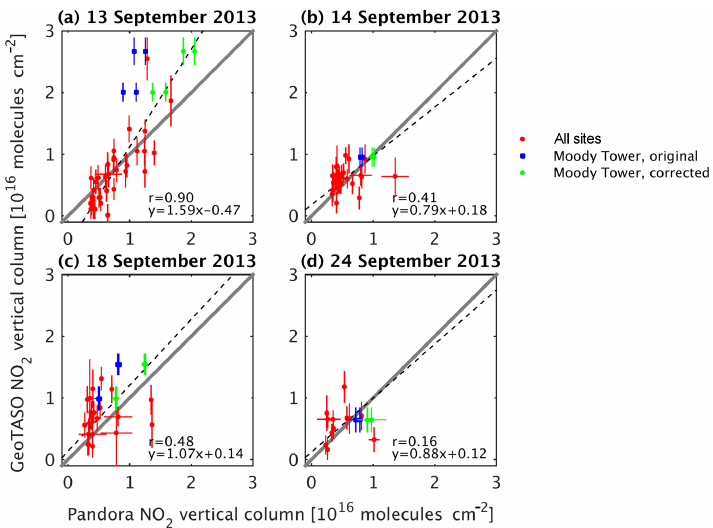
Figure 13. Pandora NO 2 vertical columns vs. GeoTASO NO 2 total vertical columns (retrieved tropospheric column plus modeled strato- spheric column) for cloud-free observations during four Houston urban flights during DISCOVER-AQ 2013. Data collected at the Moody Tower site (70m) have been corrected for the partial NO 2 column below the tower (see text). GeoTASO error bars represent fitting uncer- tainties. The gray solid line represents the 1 : 1 ratio. The black dashed line represents a reduced major axis linear regression using all sites, including corrected Moody Tower